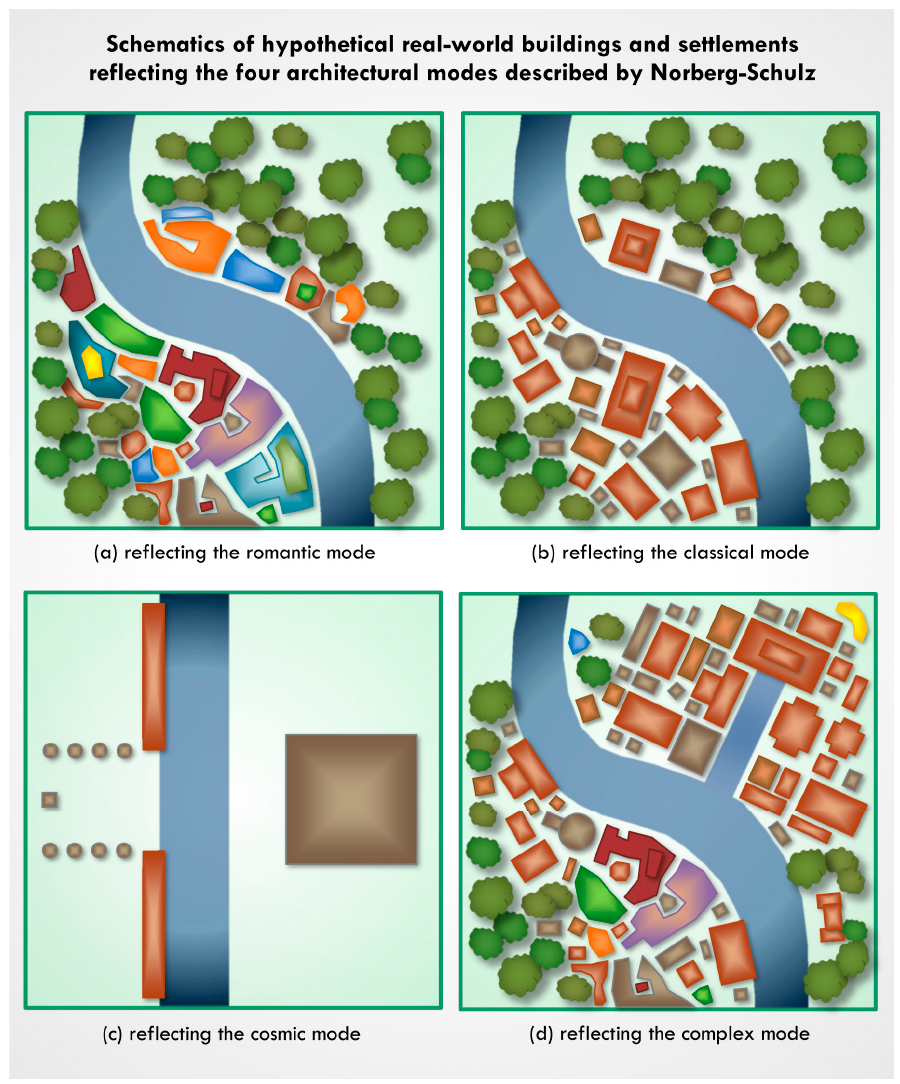
Figure 3. Norberg-Schulz’s Heideggerian phenomenological account describes four basic modes of real-world architecture. real-world